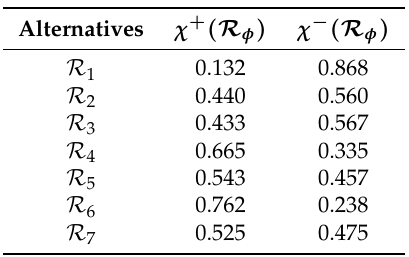
Table 15. Positive and negative outranking flows.